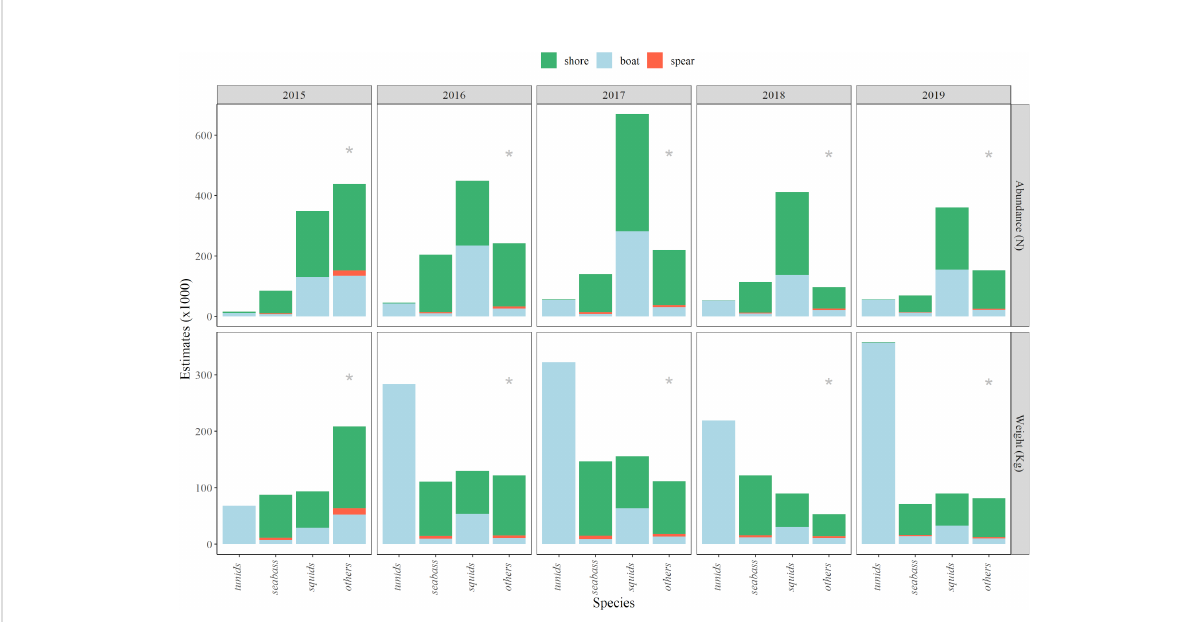
FIGURE 5 Mean values of estimated catches (i.e., between phone and email surveys, see Methods section), in terms of abundance (numbers) and weight (kg), for the main species groups caught by each fi shing mode (i.e., shore fi shing, boat fi shing, spear fi shing) during the sampling years (2015- 2019). Grey “ * ” denotes minimum abundance, based on additional notes from fi shers (see Methods